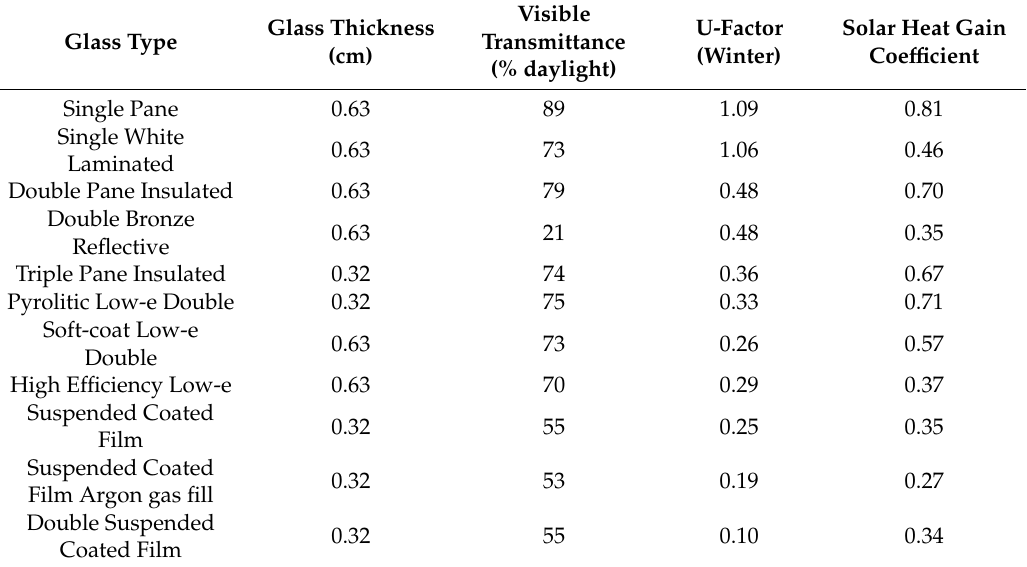
Table 1. Indicative characteristics of di ff erent glass types